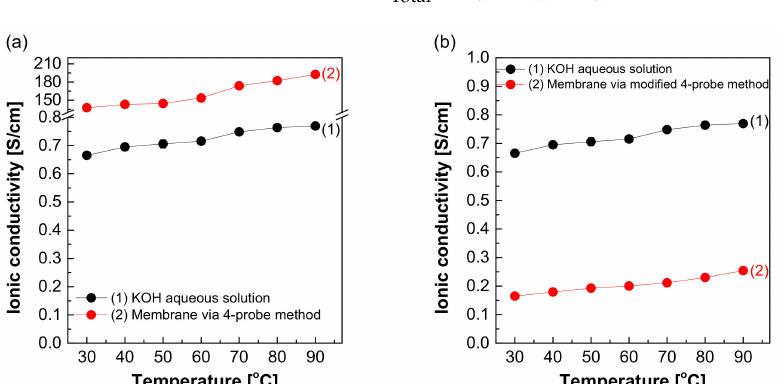
Figure 10. Hydroxide ion conductivity measured using the 4-probe method in 30 wt.% KOH solution ( a ) immersing in 30 wt.% KOH condition (Figure 3 mode), ( b ) without immersing in 30 wt.% KOH solution (Figure 4